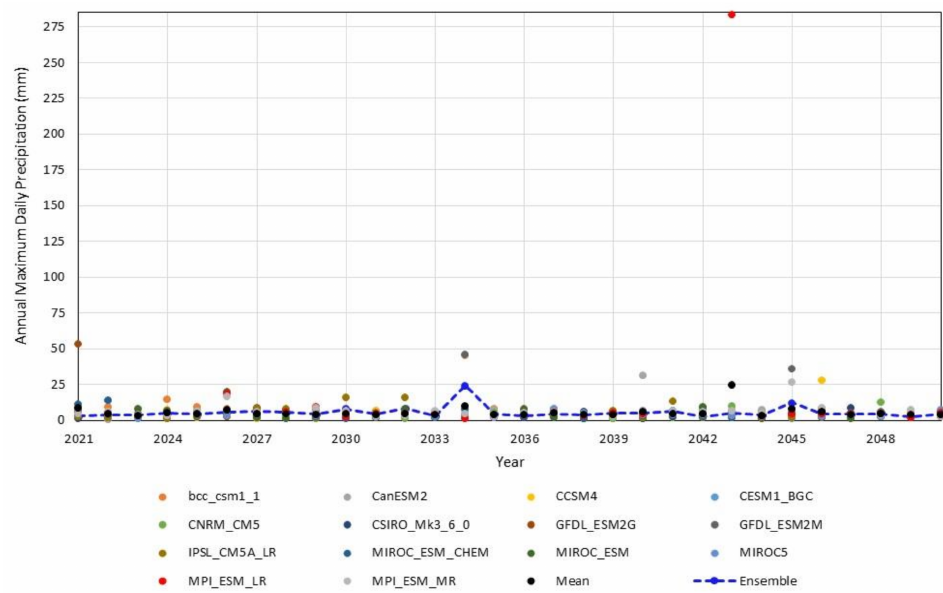
Figure 12. Annual maximum daily precipitation projected by 14 climate models under the RCP4.5 scenario for the Devil’s Creek. The dashed blue line corresponds to the ensemble. Period: 2021–2050.